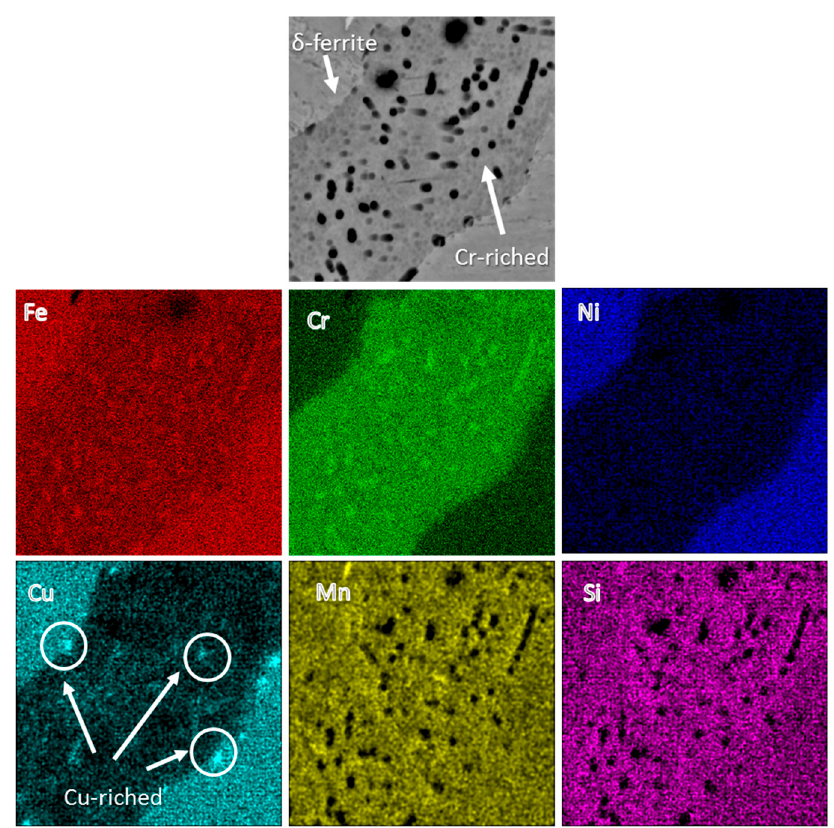
Figure 4. EDX concentration maps of the δ‐ ferrite phase. Table 2. The measured chemical composition of 17 ‐ 4 PH stainless steel micro ‐ constituents (all in wt. %).